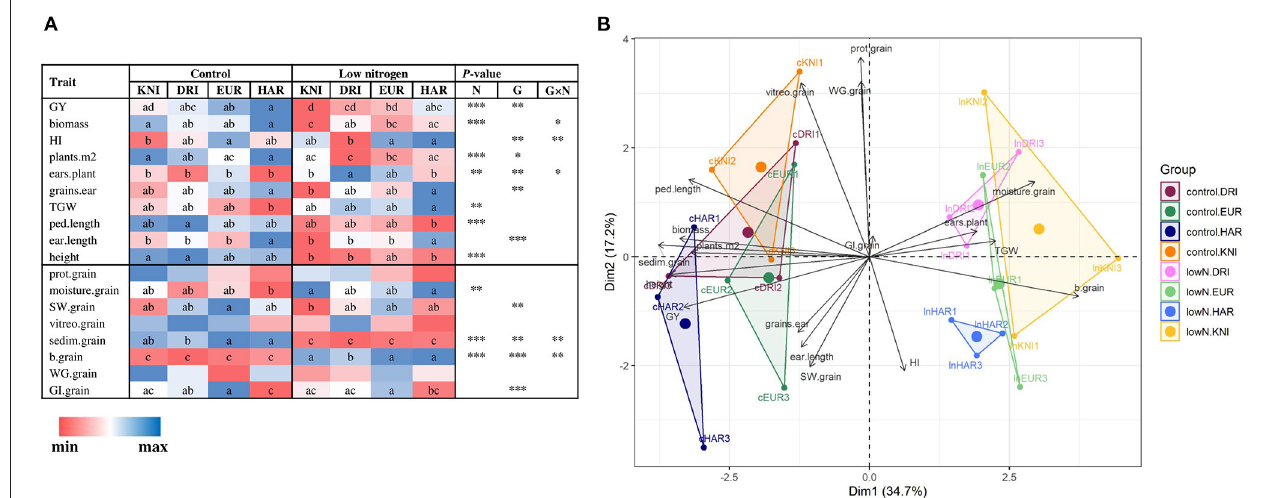
FIGURE 2 | Effects of N supply and genotypic variability on agronomic components and grain quality traits (A) and principal component analysis (B) in four varieties of field-grown durum wheat (Kiko Nick, Don Ricardo, Euroduro, and Haristide) at two N levels (control vs. low N). In (A) , the different letters differ statistically (*, p < 0.05; **, p < 0.01; ***, p < 0.001). The abbreviations are described in Supplementary Table 1